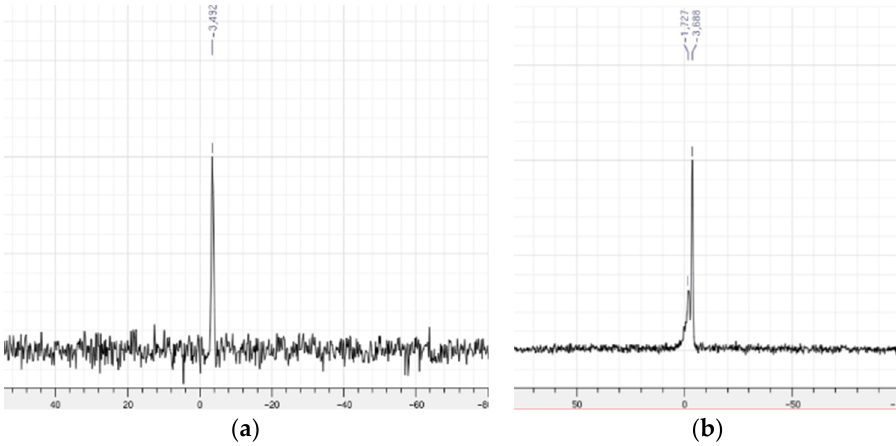
Figure 2. Solid-state 31 P NMR of MR 4 -Mo ( a ) and MR 12 -Mo ( b ) supported